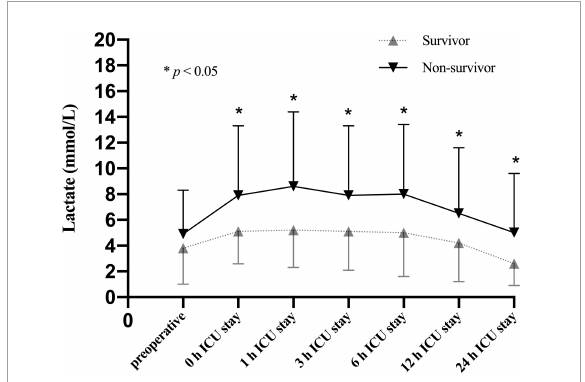
FIGURE4 Lactate levels (mean and standard deviation) of patients stratified with 30-day mortality in the CRRT group at multiple time points.